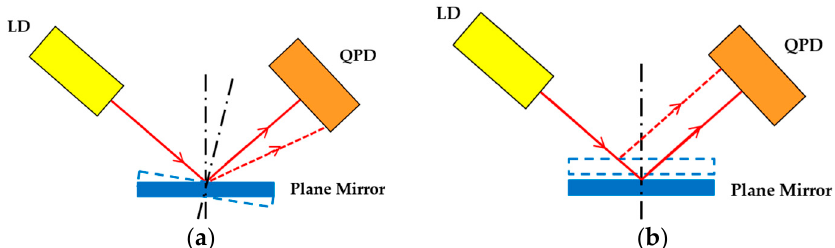
Figure 3. Sensing principle of the probe when the probe tip has a displacement ( a ) in horizontal ( b ) in vertical.